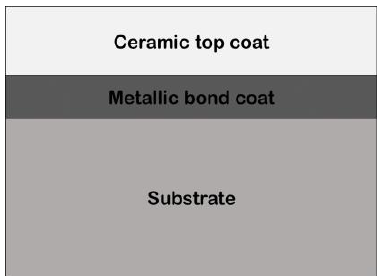
Figure 1. A schematic of a typical thermal barrier coating system showing all the layers which are from the top-bottom: Ceramic top coat, Metallic bond coat and Substrate.